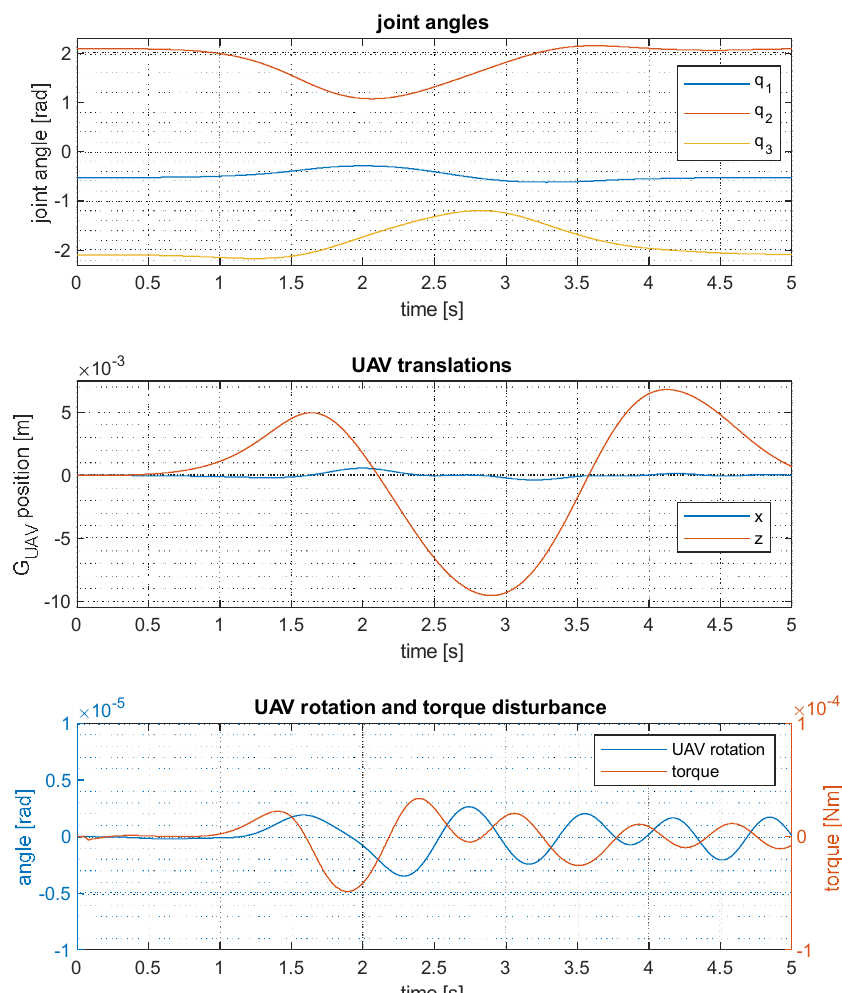
Figure 20. Manipulator ( top ) and UAV motions and torque disturbance ( middle and bottom ) for the circular trajectory task with the 3-DOF UAM using the extended generalized Jacobian.